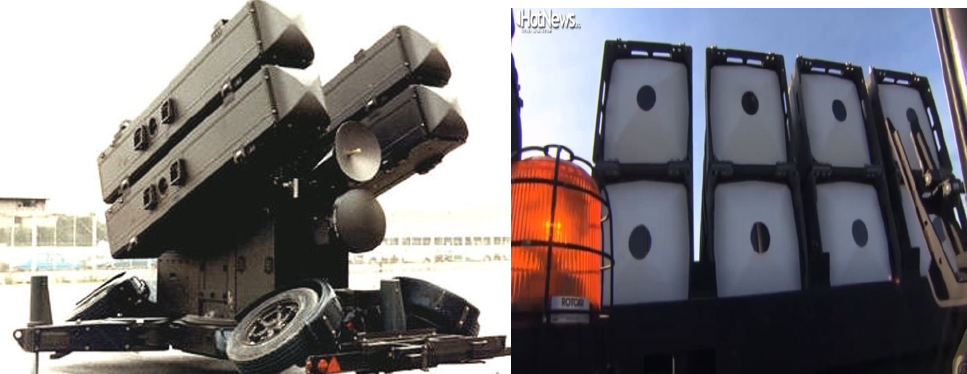
Figure 2. Aspide 30 system ( left ) and Aster system ( right